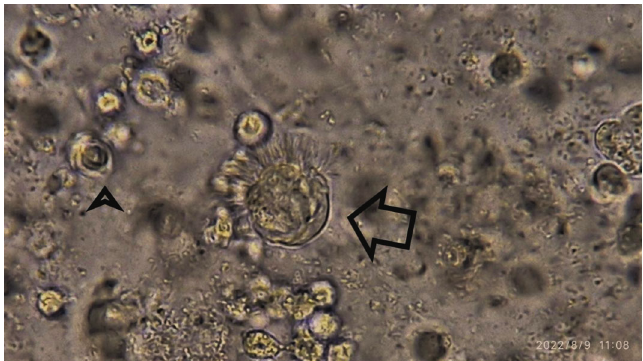
Figure 1: Lophomonas blattarum in the sputum sample, note to fl agellate in half of the surface of the protozoa (large arrow represents Lophomonas ; arrowhead represents